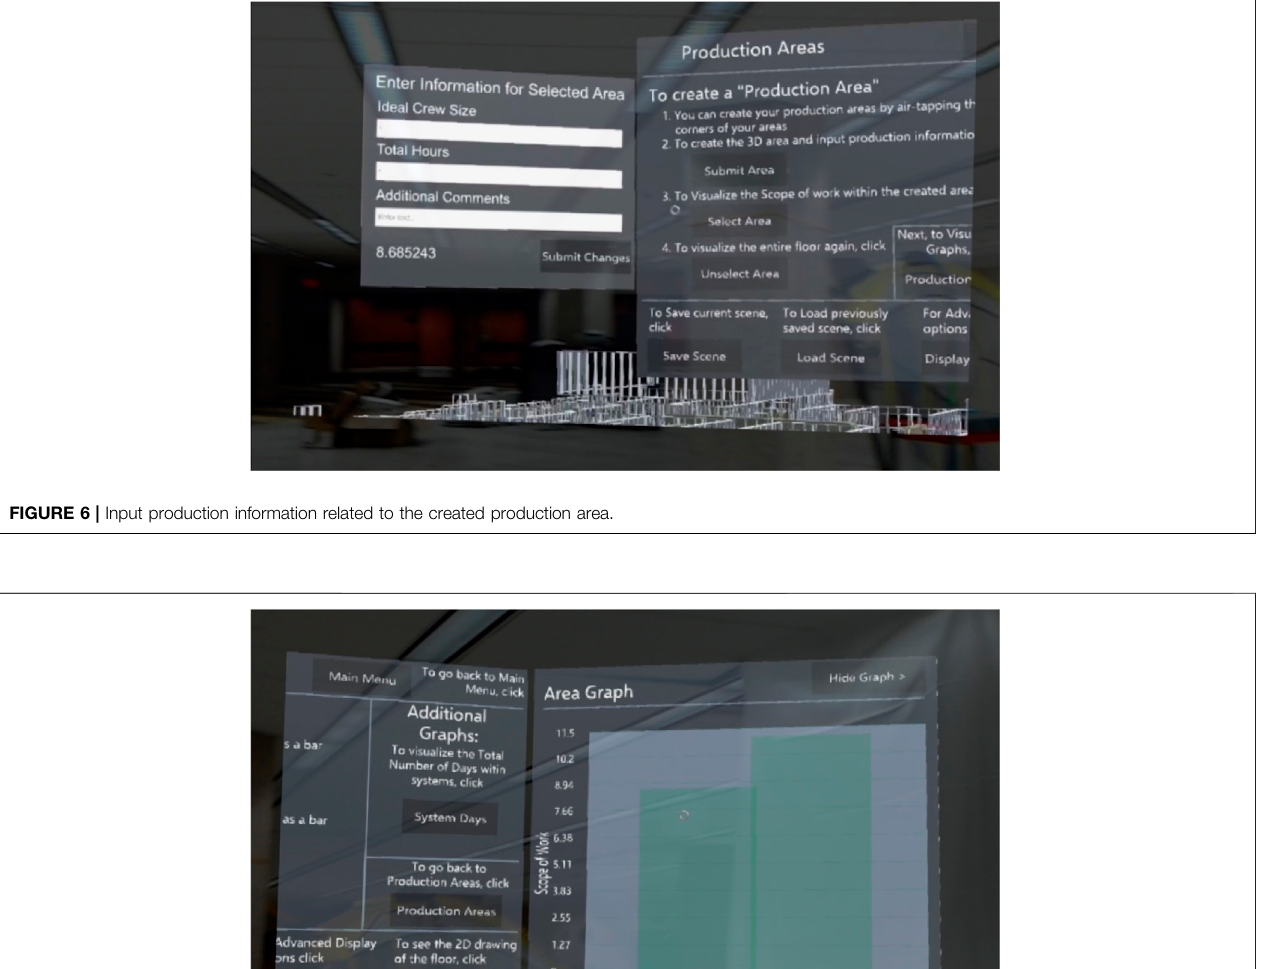
Frontiers in Built Environment |